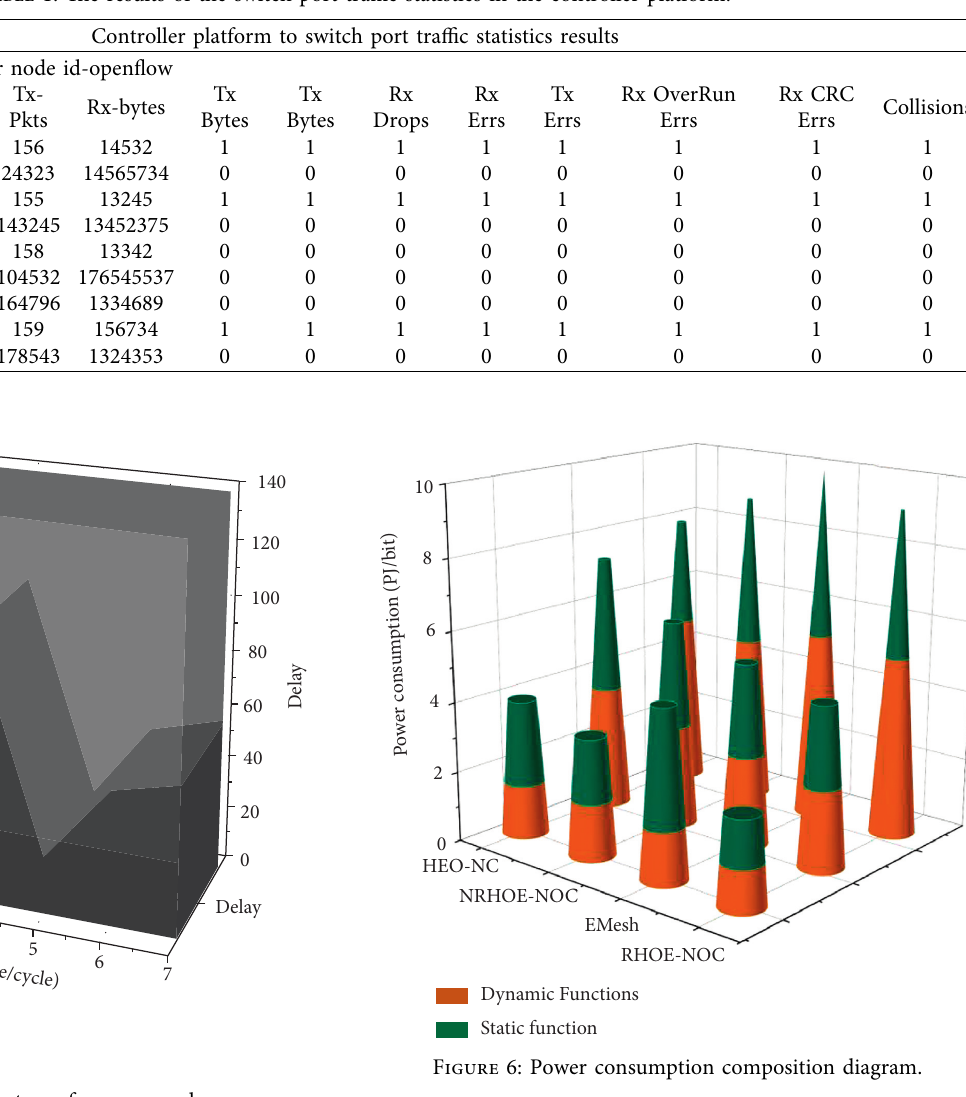
Figure 5: Delay throughput rate performance and average power overhead for two routing algorithms.